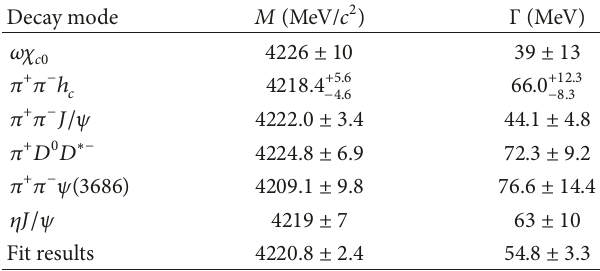
Table 3: The parameters for 𝑌(4220) from different decay modes; the last line shows the fit